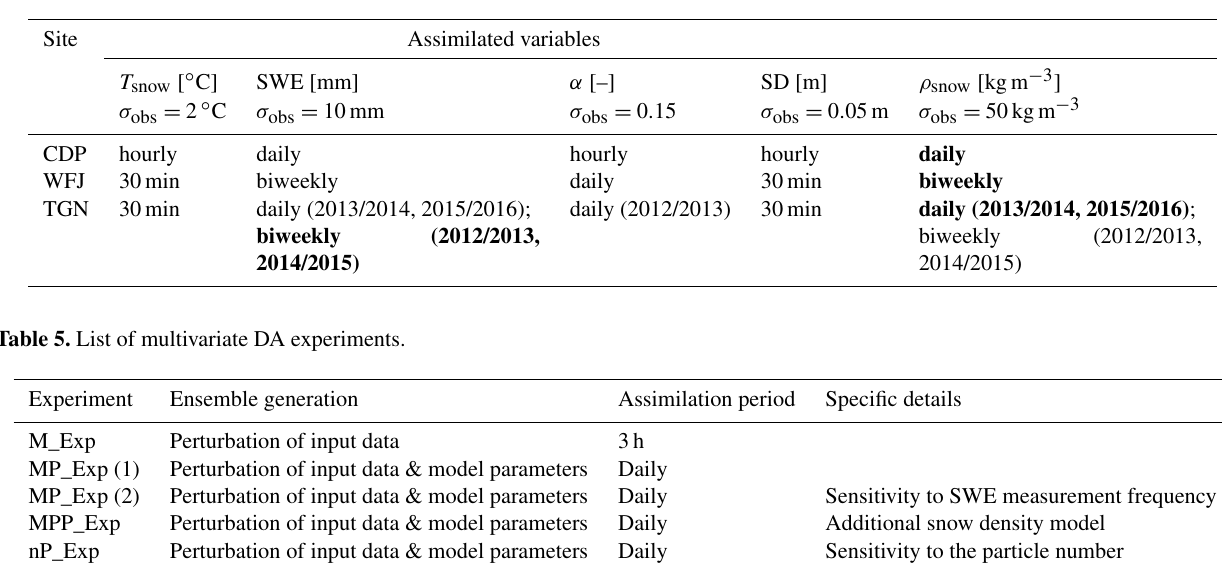
Table 4. Measurement frequency of the assimilated variables at each experimental site: snow surface temperature ( T snow ), SWE, albedo ( α ), snow depth (SD), and snow density ( ρ snow ). Observational uncertainties ( σ obs ) are reported; variables indirectly estimated are highlighted in bold.